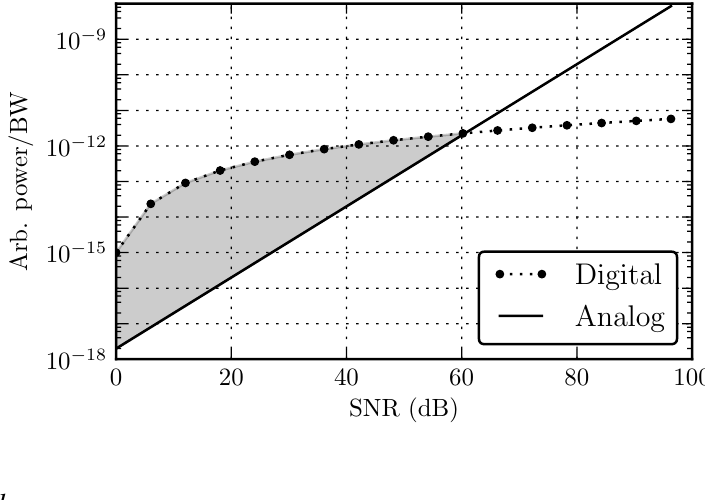
Figure 2. Analog and digital power requirements for signal processing as a function